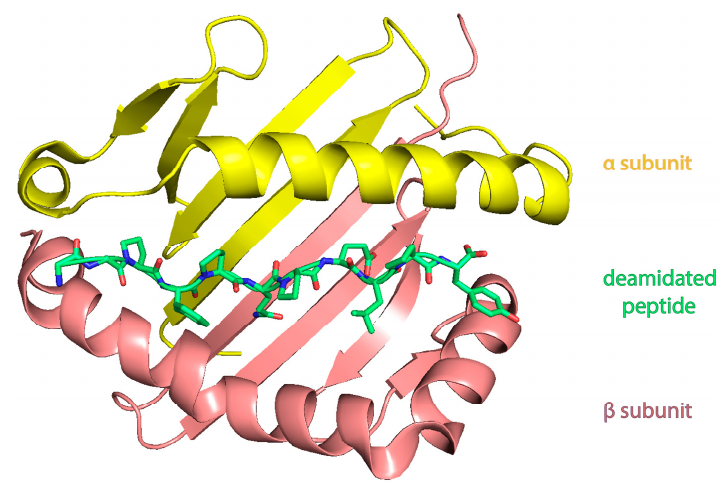
Figure 5. 3D reconstruction of DQ α 5 - β 2 -binding cleft with a deamidated α -gliadin peptide (green), using PyMOL (PBD ID 1S9V) [81].